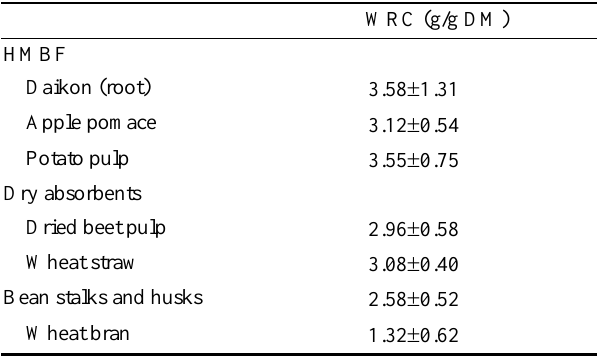
Table 3. Water retention capacity (WRC) of some HMBF